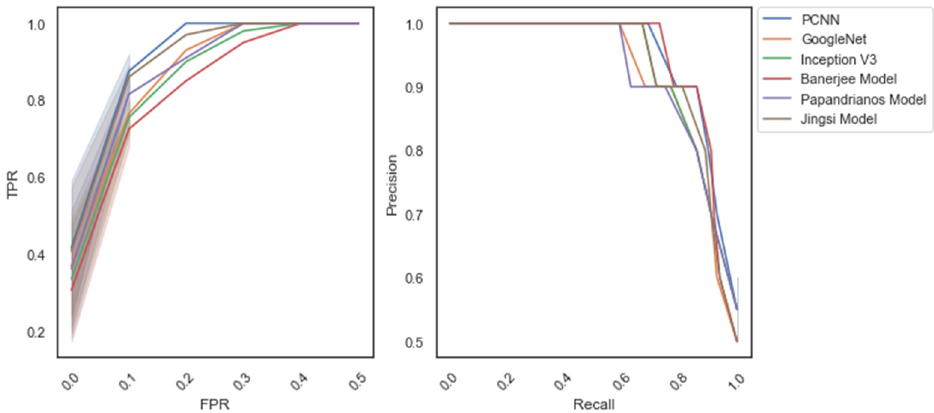
Figure 14. Receiver operating characteristic (ROC) and precision–recall curve: dataset_1.